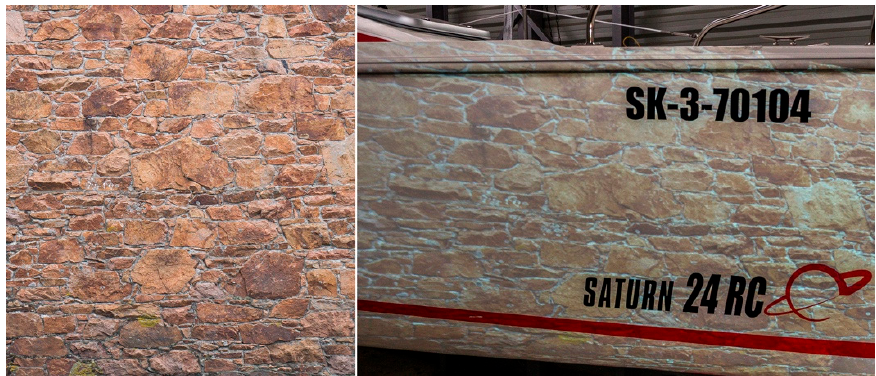
Figure 12. Left—the sample texture used during SfM imaging; right—its projection on the hull.